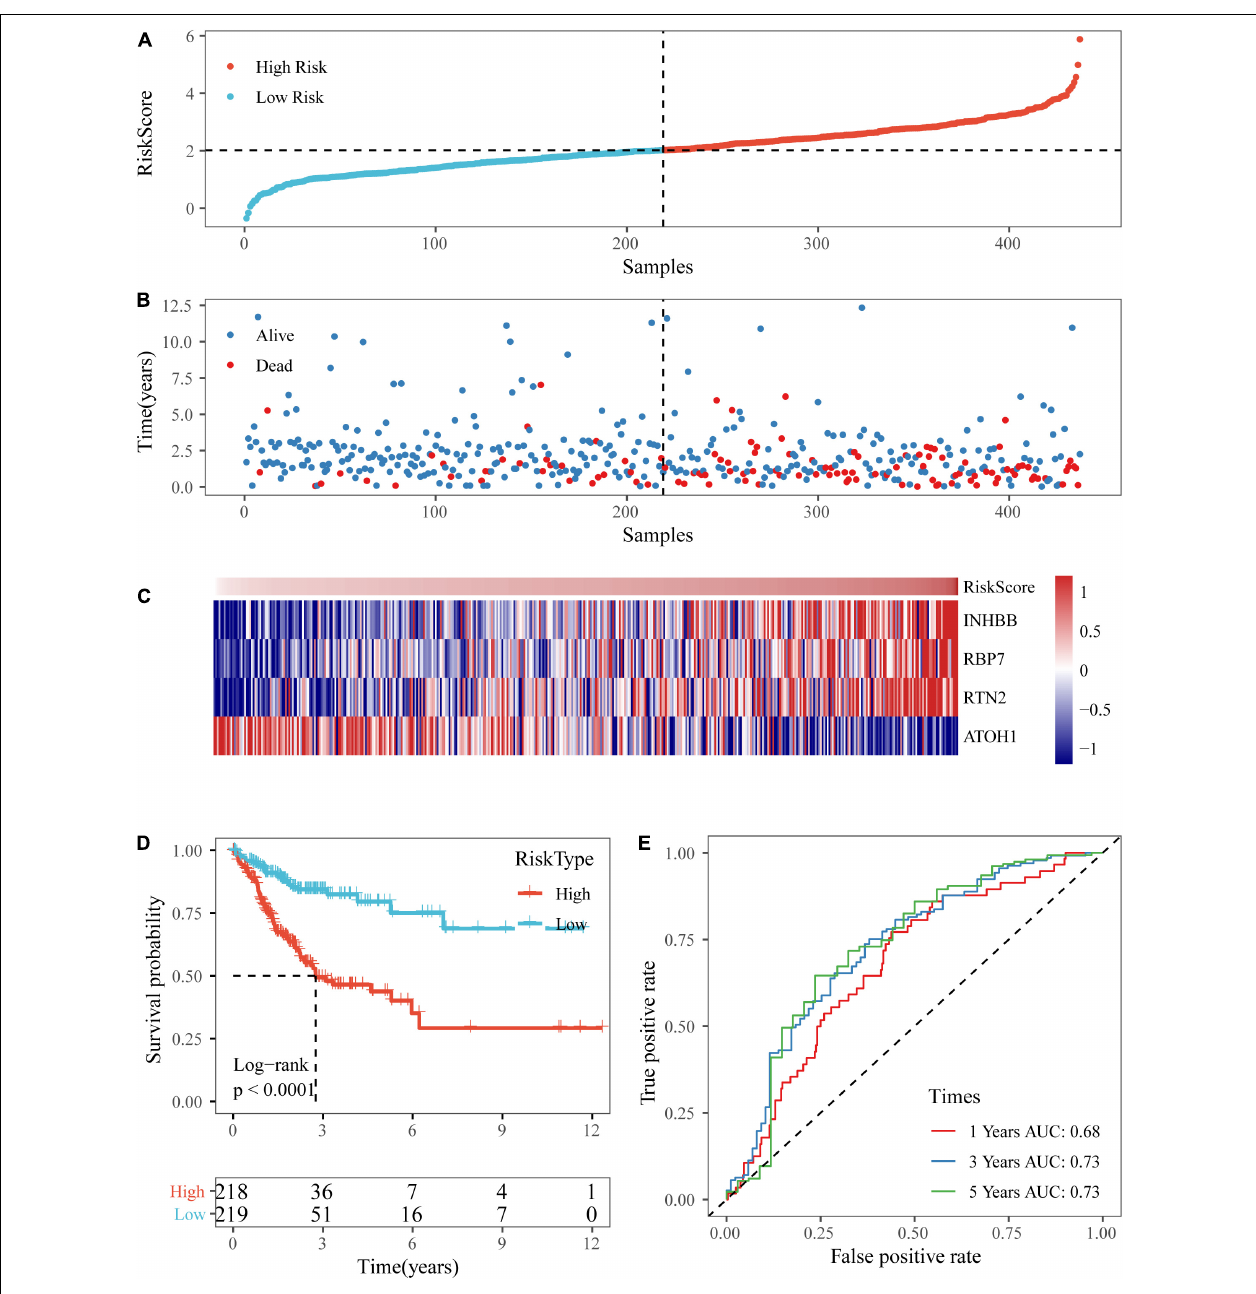
FIGURE 8 | Verification of the four-gene signature in entire TCGA datasets. (A,B) The distribution of risk scores in the entire TCGA dataset and the distribution of corresponding survival states. (C) Heatmaps of gene expression in the risk score model. (D,E) KM curves and ROC curves of the risk score in entire TCGA datasets.